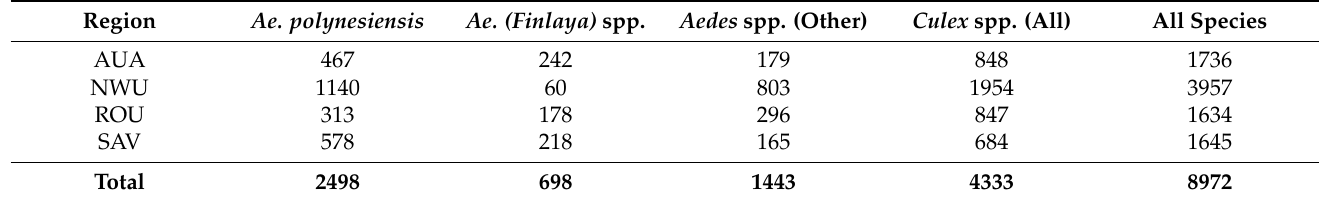
Table 1. Number of female mosquitoes caught by species category and region, Samoa 2018. Regions